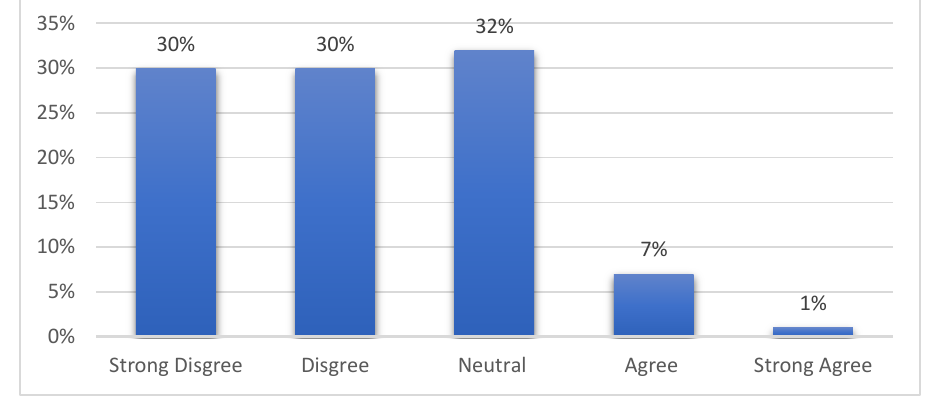
Figure 3: Availability of